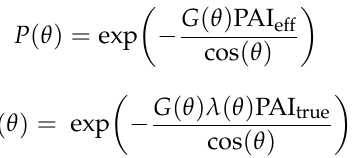
Figure 5. Synthetic digital hemispherical photography (DHP) of ( a ) Plot2 in leaf-on condition, ( b ) Plot2 in leaf-off condition, ( c ) Plot30 in leaf-on condition, and ( d ) Plot30 in leaf-off condition.